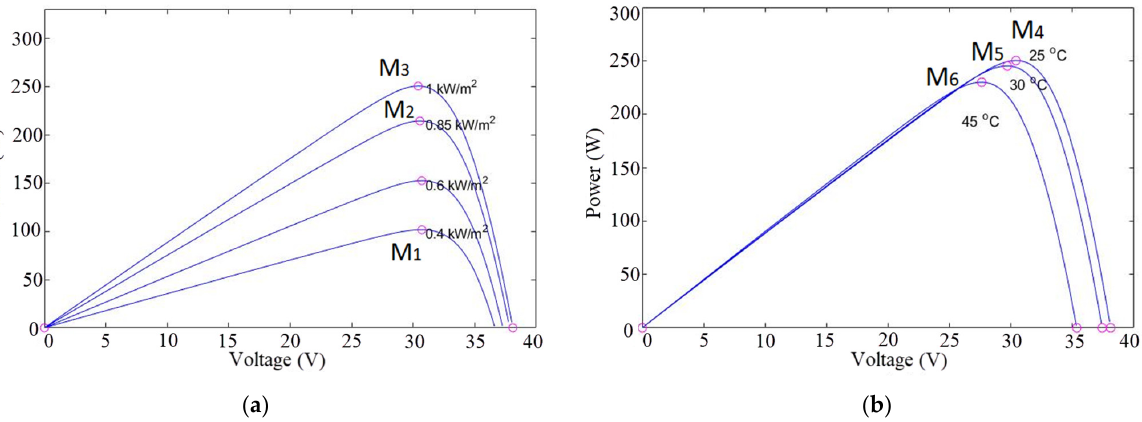
Figure 2. Power obtained from PV panels for different ( a ) solar radiation values and ( b ) module temperature values. Table 1. Power and Voltage at Maximum Power Points.